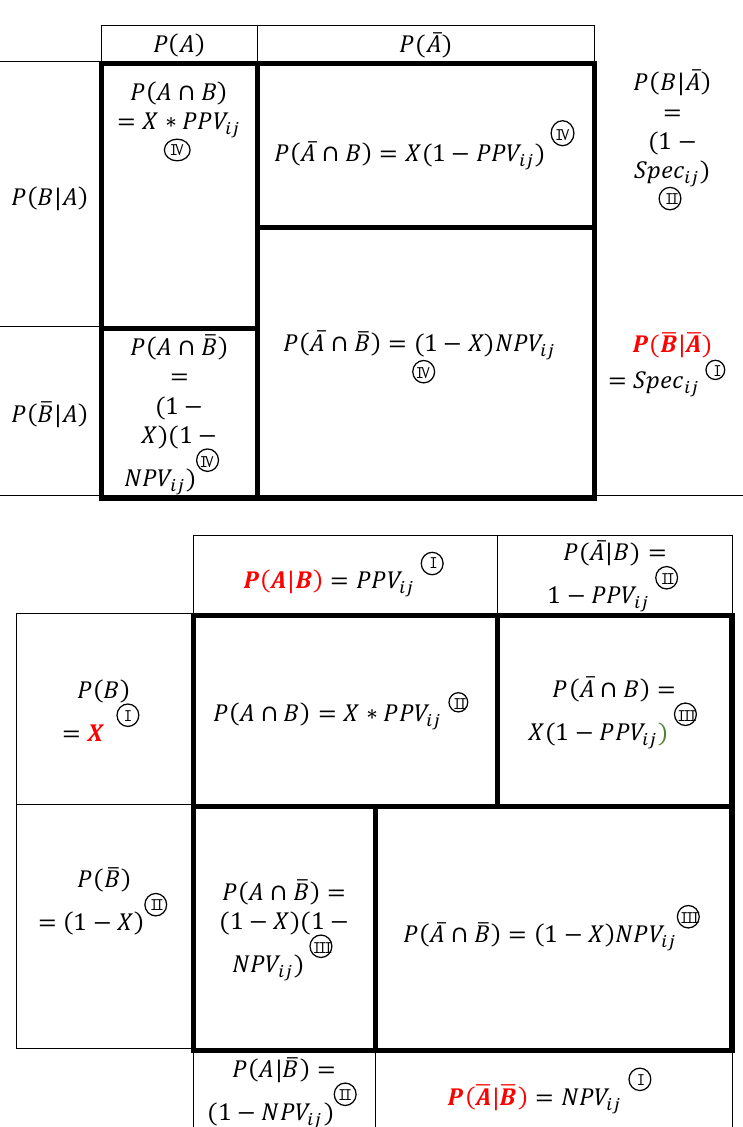
Figure 11. Steps for algebraic computing of the sensitivity (𝑆𝑒𝑛𝑠 (𝑆𝑝𝑒𝑐 = 𝑃(𝐵̅|𝐴̅) ), the positive predictive value (𝑃𝑃𝑉 𝑖𝑗